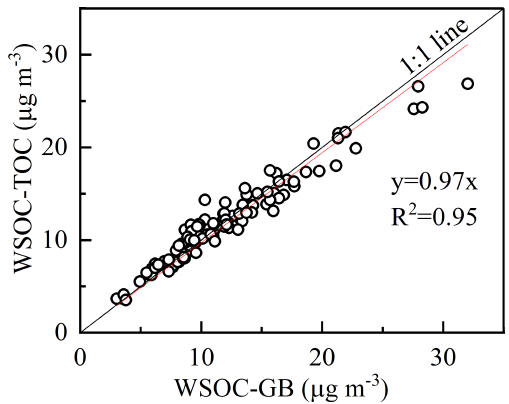
Figure 4. Correlation of WSOC mass concentrations measured with the GasBench II–IRMS and TOC